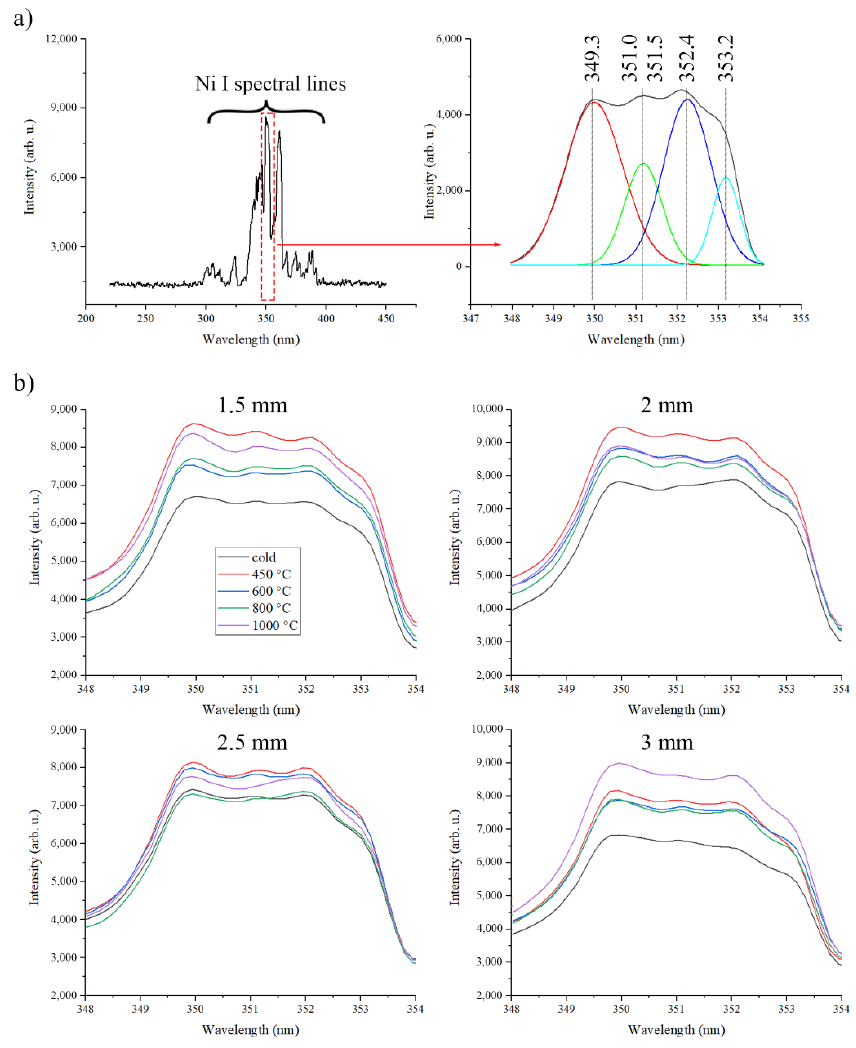
Table 2. OES lines attributed to the measured spectra [31] .